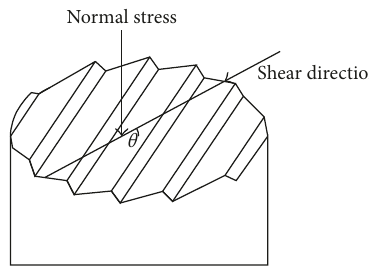
Figure 7: Shear direction of